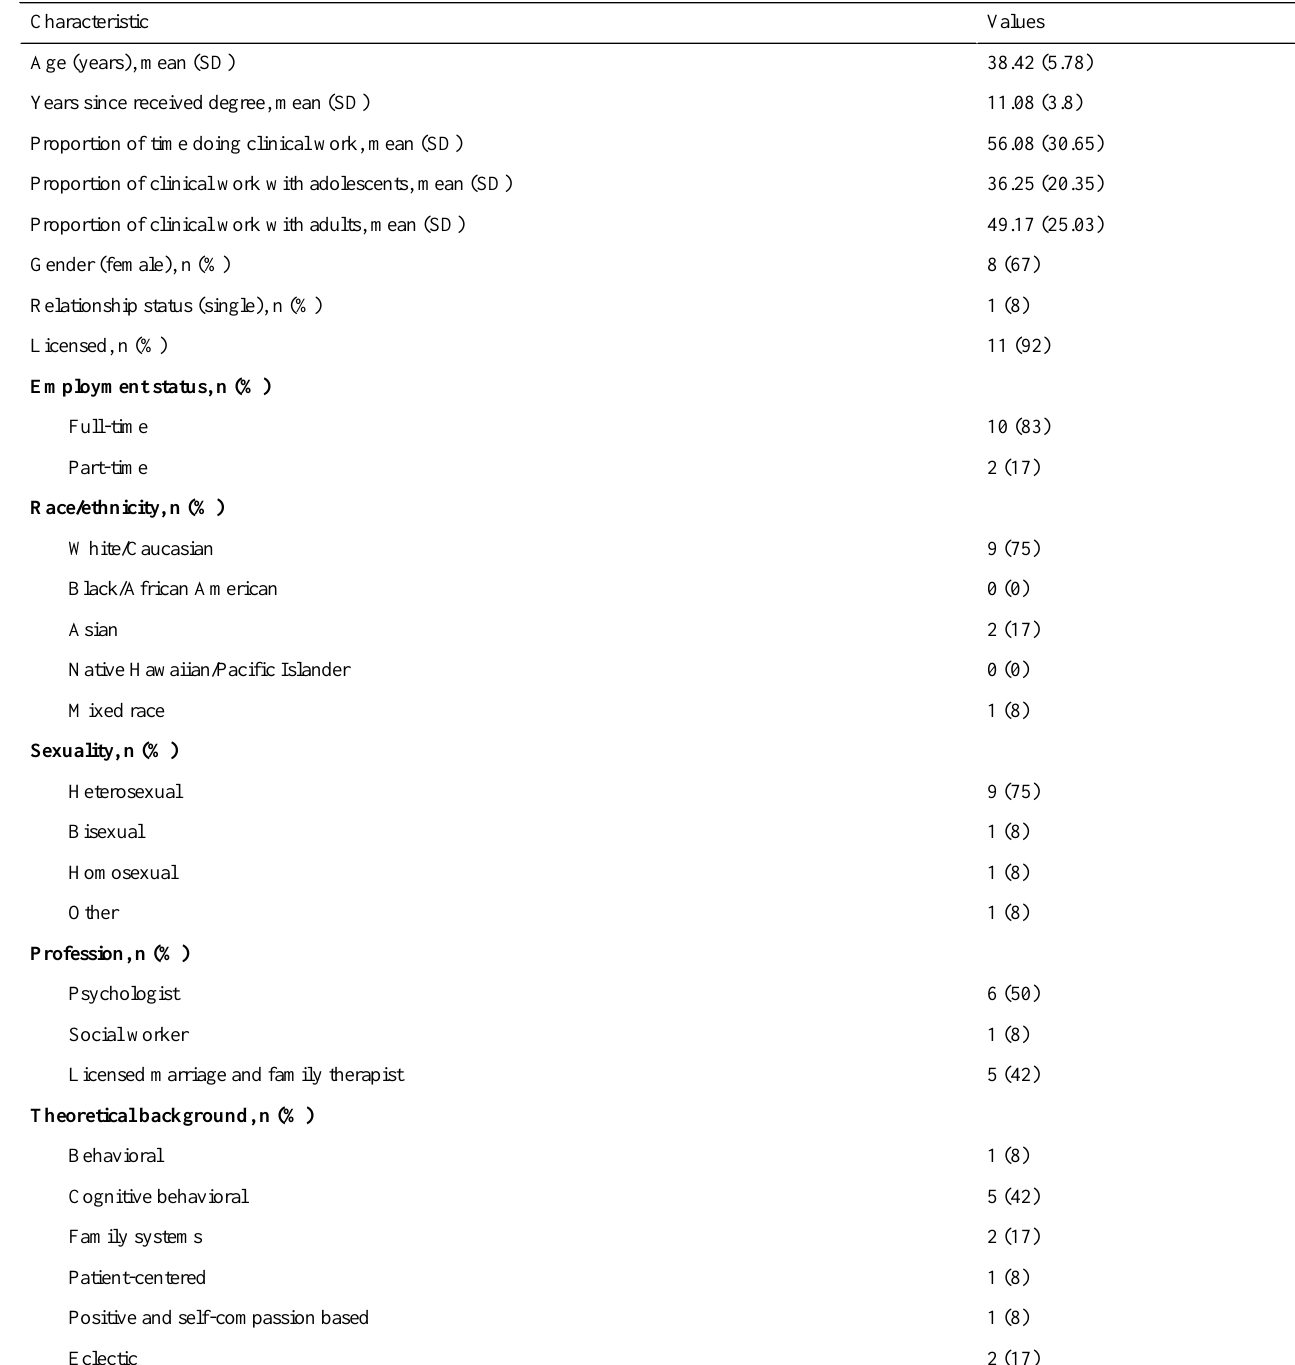
Table 2. Demographical data of the mental health care providers in this study (n=12).